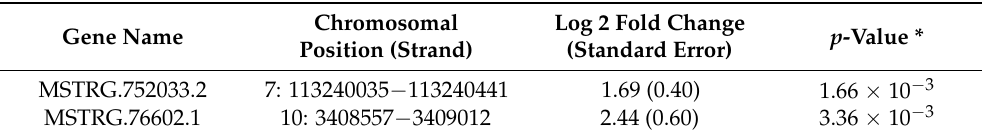
* p -value adjusted for multiple